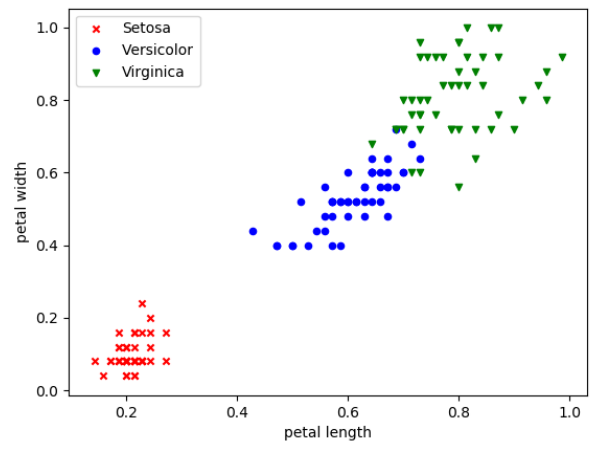
Figure 4. The relationship between features and types in the iris data set.